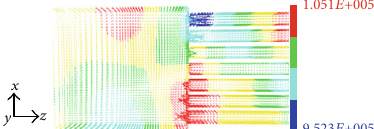
Figure 9: Instantaneous velocity vector and pressure fi elds in injectors and plenum